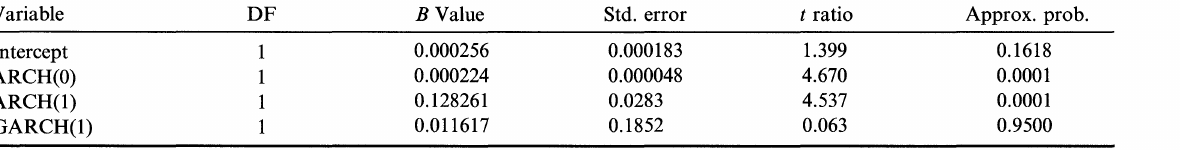
FIGURE 6 Compass rose graph for a simulated series. TABLE III Results of SAS fit of our simulation data to a GARCH(1,1) model. The results falsely suggest that the data follow an ARCH(l)